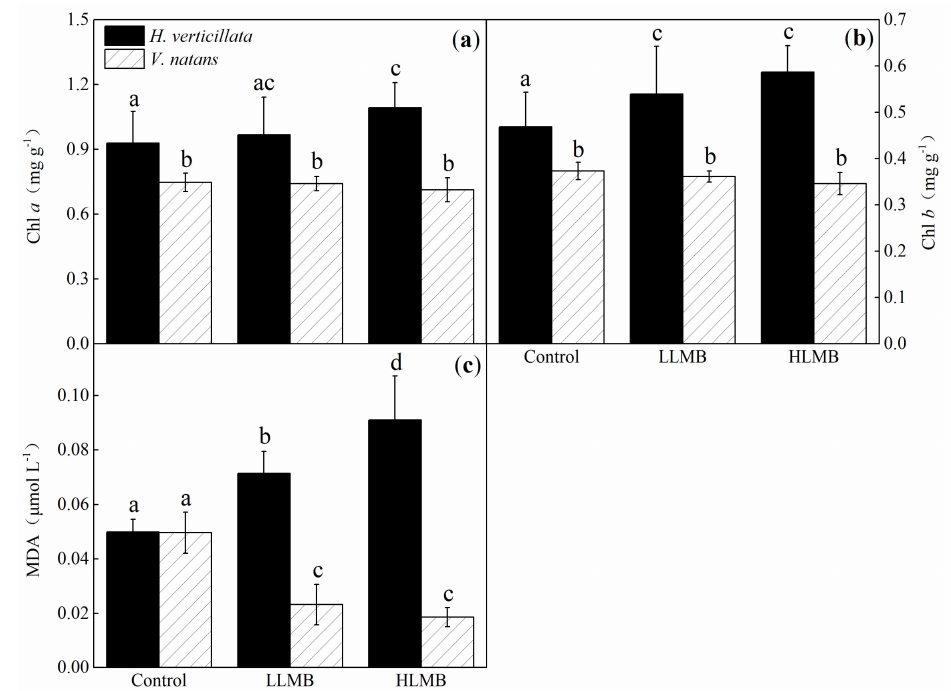
Figure 6. Chlorophyll a ( a ), Chlorophyll b ( b ), and MDA ( c ) of H. verticillata and V. natans . Factor was LMB (0, 425 g m − 2 , and 850 g m − 2 ). The error bars represented a standard deviation. Means with different letters (a, b, c, and d) were significantly different ( p <